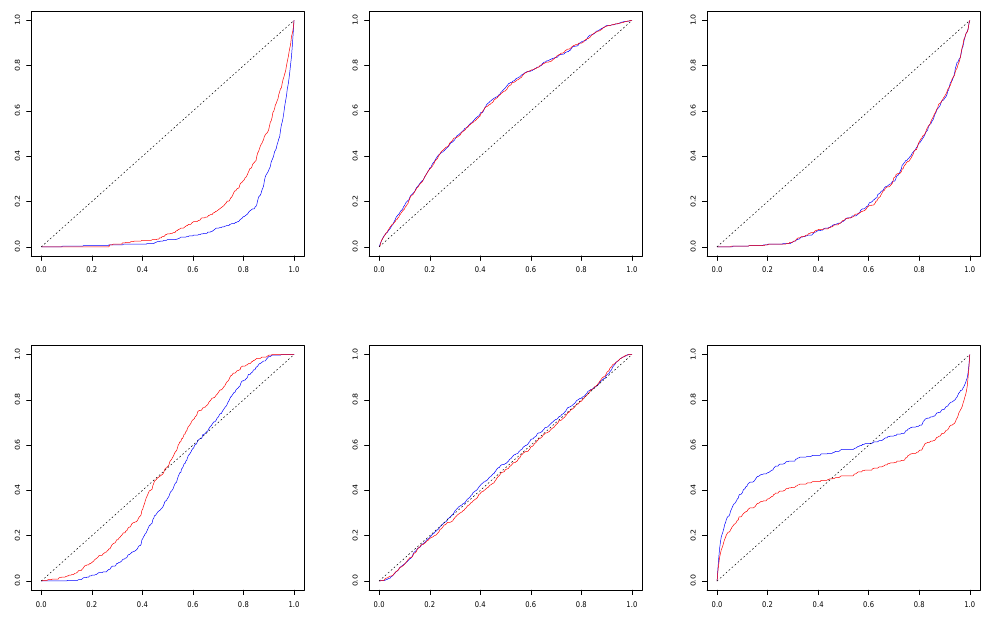
Figure 4. Conditional Cumulative Distribution Function Estimates (blue: h = 0; red: h = 1) ( Upper row : VIX 2 | rsp; Lower row : rsp | VIX 2 ; Left : A = (0, 0.05]; Middle : A = [0.45, 0.55]; Right : A = [0.95,